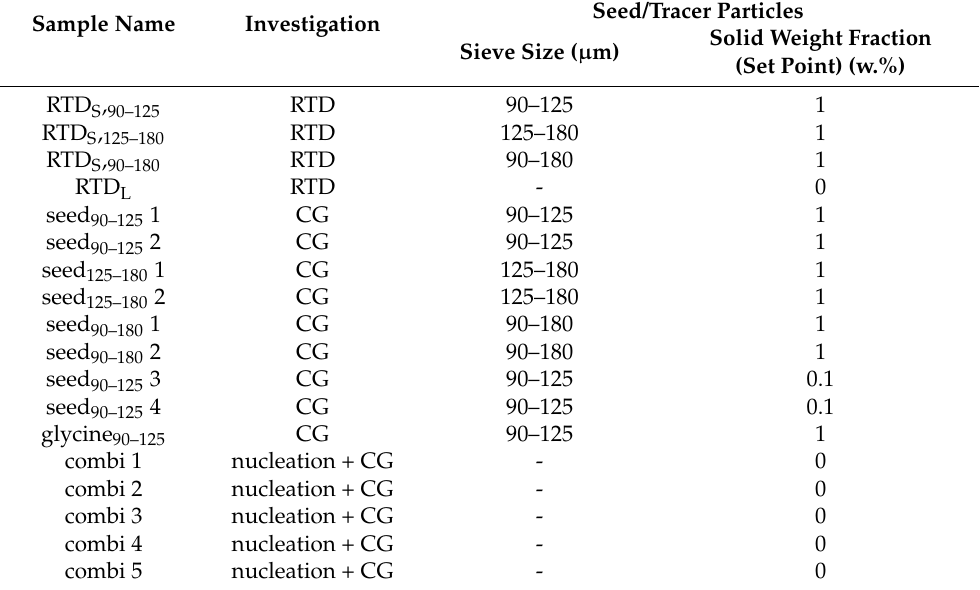
Table 1. Overview of